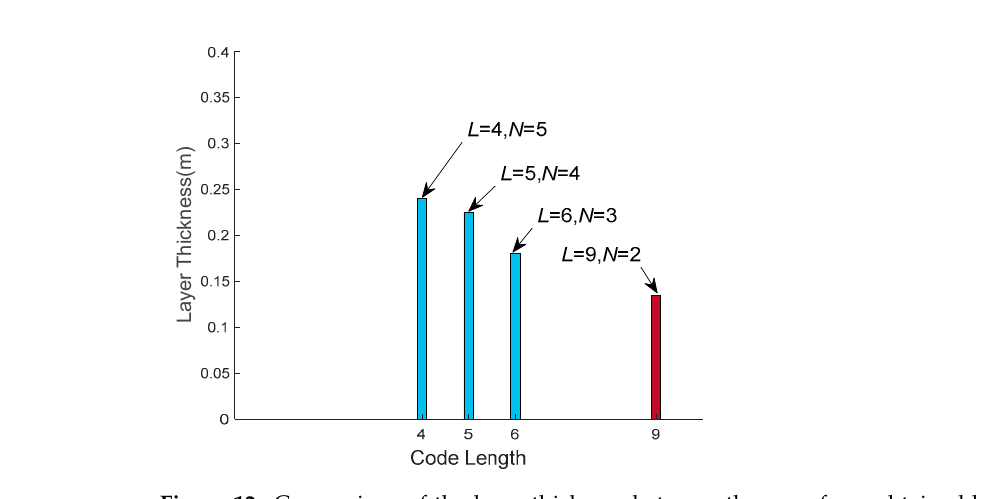
Figure 12. Comparison of the layer thickness between the waveform obtained by the proposed WSAP method and the other waveforms. The waveform ( N = 2, L = 9) obtained by the proposed WSAP method achieves the smallest layer thickness.